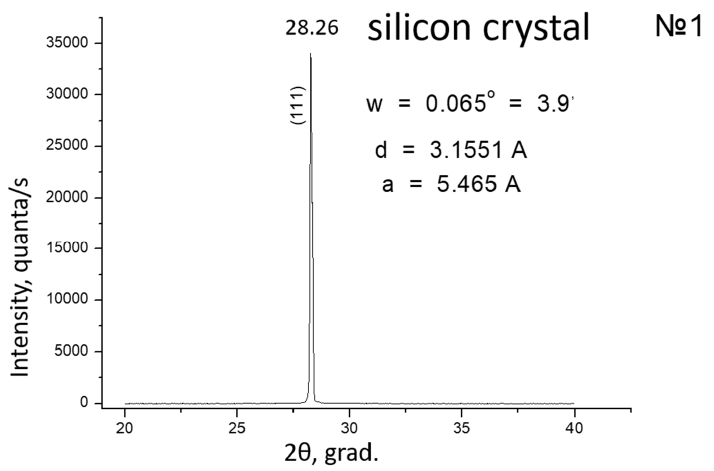
Figure 8. X-ray diffraction pattern of a silicon single crystal with an indication of the X-ray scattering angle 2 θ above the diffraction peak and the Miller index of the crystallographic plane. Calculated from the angular position of the diffraction peak 2θ = 28.26 ° (Figure 8), the lattice constant of a silicon single crystal was a = 5.465 (±0.0005) Å , and the lattice constant of the same crystal from the database is a (cid:2868) = 5.4301 Å . Taking into account the values a and a (cid:2868) , as well as the mechanical characteristics of the silicon crystal, including the Young’s modulus of elasticity E (cid:2909) = 109 GPa ( GPa —gigapascal in Si system) and the Poisson ratio γ = 0.266 [56], the value of the micro-stress in a silicon single crystal equal to σ = 0.954 GPa is calculated by the formula (26). This value of the micro-stress must be compared with the average plasmon energy, which for a single silicon crystal is calculated by the empirical formula (25) from the plasmon dispersion curve shown in Figure 9.